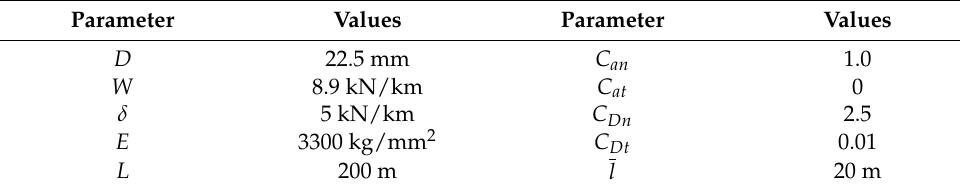
Table 3. Parameter values of towing cable used for simulation.